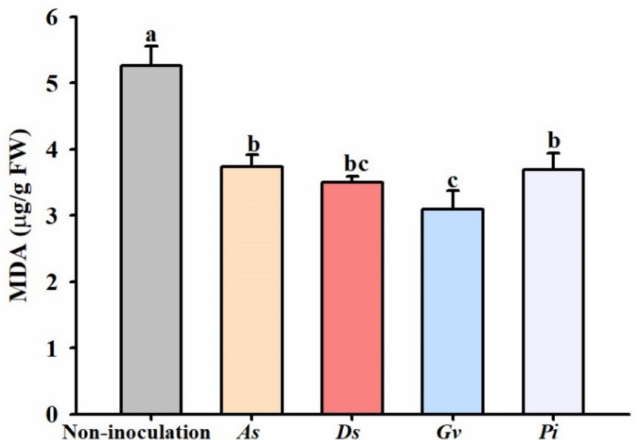
Figure 6. The effect of inoculation with Acaulospora scrobiculata ( As ), Diversispora spurca ( Ds ), D . ver- siformis ( Dv ), and Piriformospora indica ( Pi ) on leaf malondialdehyde (MDA) concentrations of lane late navel orange trees. Data (means ± SD, n = 4) are significantly different ( p < 0.05) if followed by different letters above the